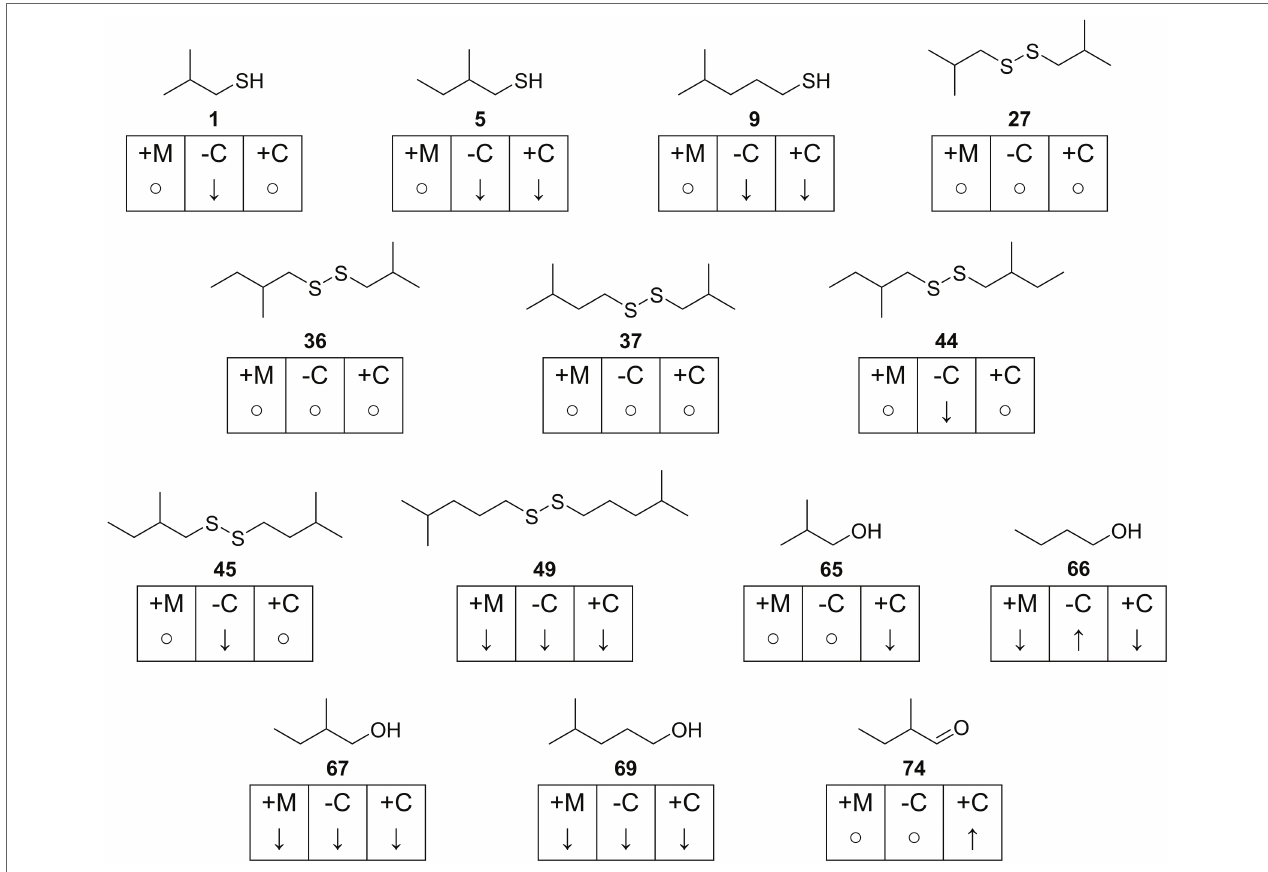
FIGURE 2 | Overview of most abundant compounds found in Clostridioides difficile 630 Δ erm . Concentration changes for each compound are indicated with ↑ (increase), ↓ (decrease or not detected) and ○ (fold change < 1.5) and given for each test medium in reference to CDMM. +M: CDMM+M; -C: CDMM-C; +C: